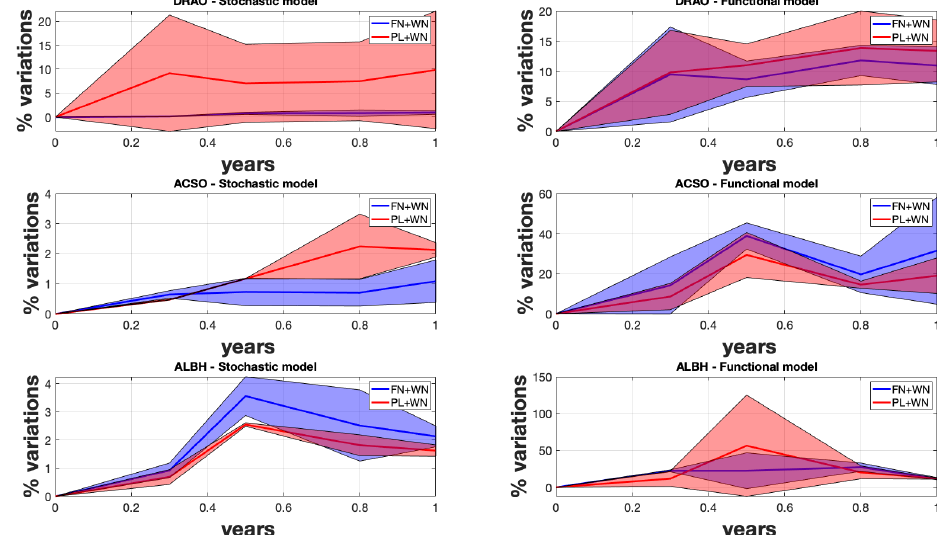
Figure 2. Percentage of variations in the estimated parameters included in the stochastic and functional models when varying the length of the daily position GNSS time series corresponding to the stations DRAO, ASCO, and ALBH. The statistics are estimated over the eastern and northern coordinates. Table 4. Statistics on the error when fitting the ARMA and FARIMA model to the residual time series for each coordinate of the stations ALBH, DRAO and ASCO based on the PL + WN stochastic noise model. Correlation between the distribution of the residuals and the normal (corr. normal) and the Lévy α –stable distributions (corr. Lévy). The last column is the Anderson–Darling test. Lévy or normal mean the type of distribution used as the null hypothesis (1 not rejected; 0 rejected). ARMA (err. in mm) FARIMA (err. in mm) Corr. normal Corr. Lévy AD test (Lévy) AD test (normal) DRAO